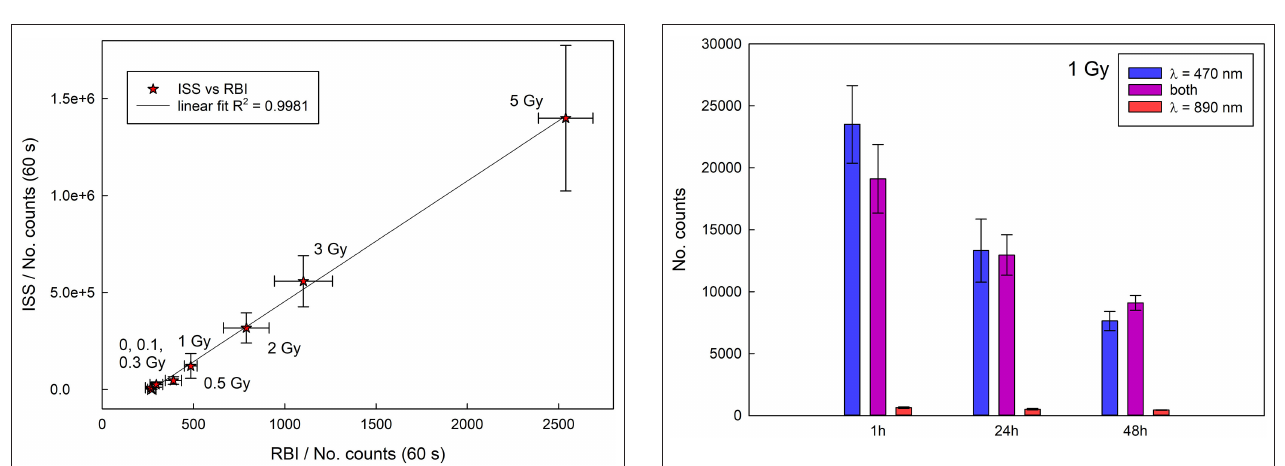
FIGURE 6 | Signal stability for samples irradiated to 1Gy (data acquired with Reader